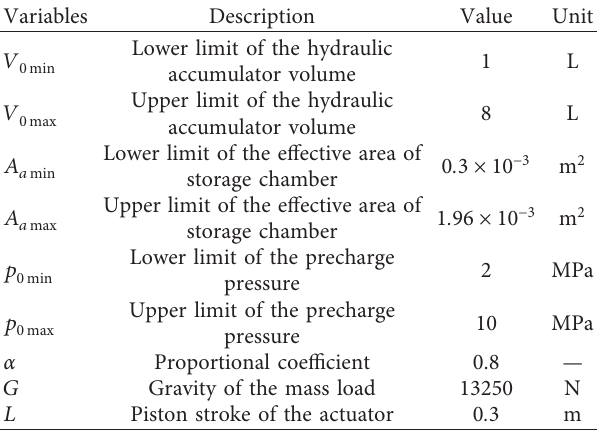
Table 1: System parameters utilized in the SA.